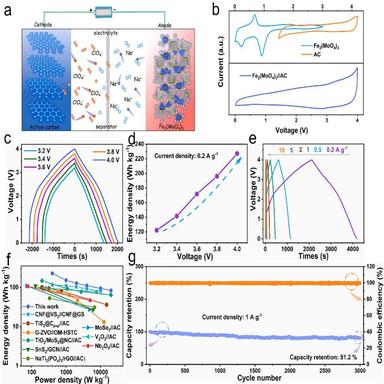
(a) Schematic configuration of the thus-assembled L-FMO assemblies//AC SIC device. (b) CV profiles of L-FMO assemblies and AC in half-cells (top) and full cell of SIC (bottom). (c) Galvanostatic charge/discharge voltage profiles at different voltage windows (current density, 0.2 A g− 1 ). (d) Corresponding energy density of the SIC with the expanding voltage window at a current density of 0.2 A g− 1 . (e) The rate performance of L-FMO assemblies//AC full cells. (f) Ragone plots in comparison with the result